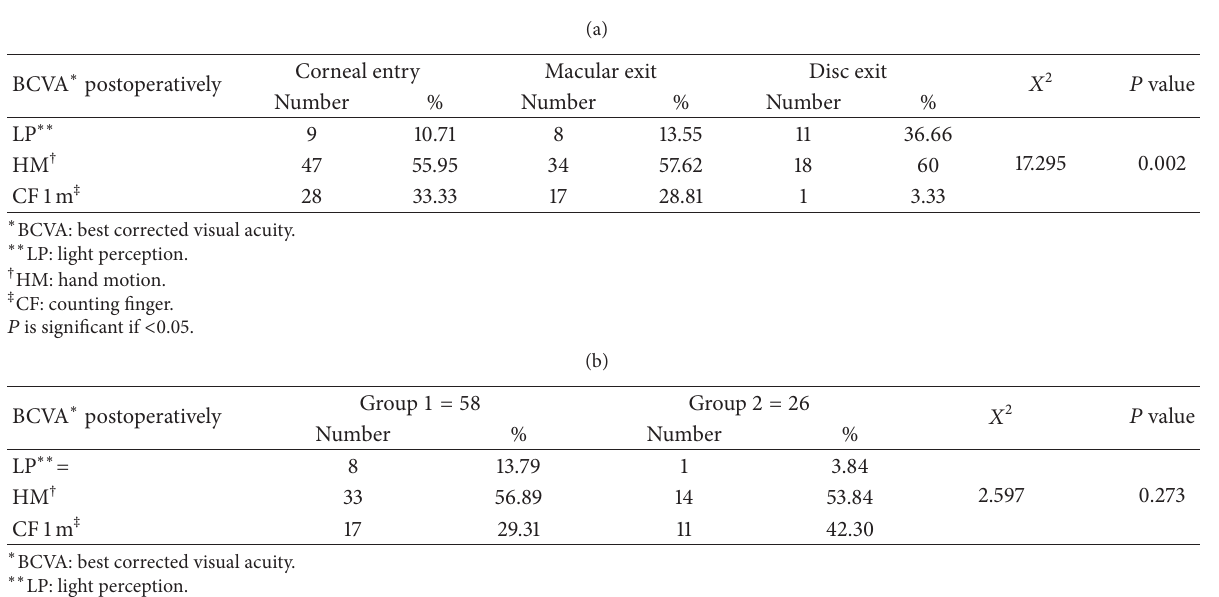
Table 6: (a) Relation of the gunshot and visual acuity in the 2 groups. (b) Postoperative visual acuity in patients with corneal entry. (c)